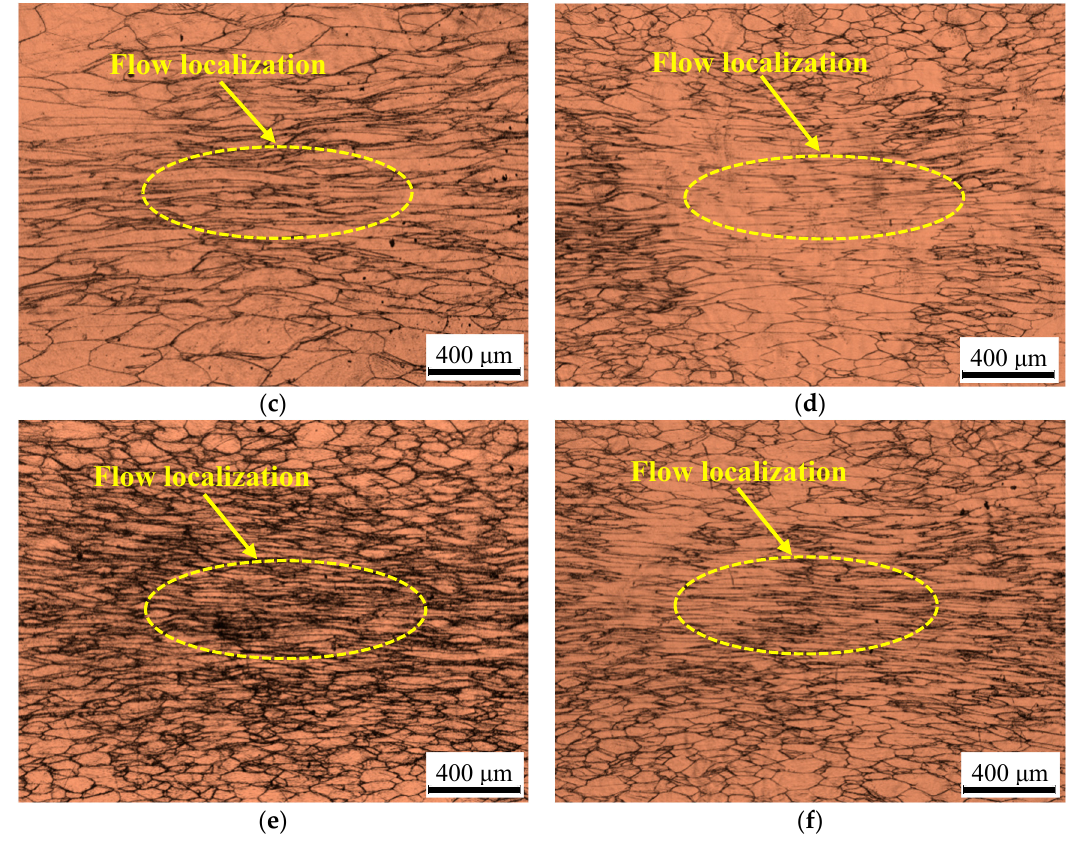
Figure 12. Optical microstructures of the coarse-grained ( a – c ) and fine-grained ( d – f ) alloys in the flow instability region at a strain of 0.8 and deformation conditions of (( a ) and ( d )) 850 °C/10 0 s -1 , (( b ) and ( e )) 850 °C/10 -1 s -1 , and (( c ) and ( f )) 900 °C/10 0 s -1 .